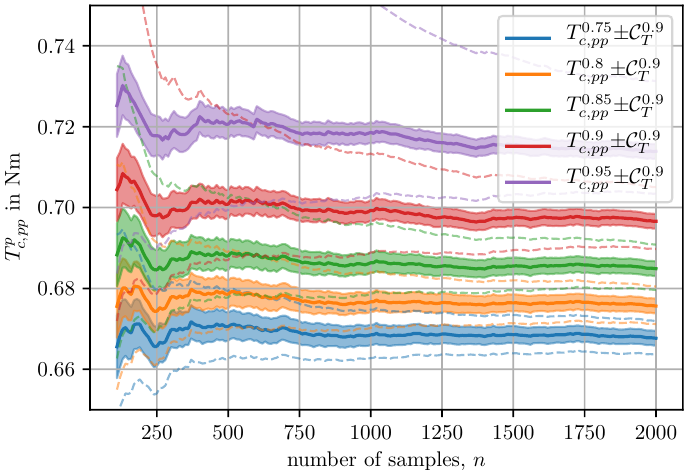
Figure 11. Different cogging torque quantile values together with the 90% confidence values as a function of the actually available samples n ; dashed lines correspond to the confidence